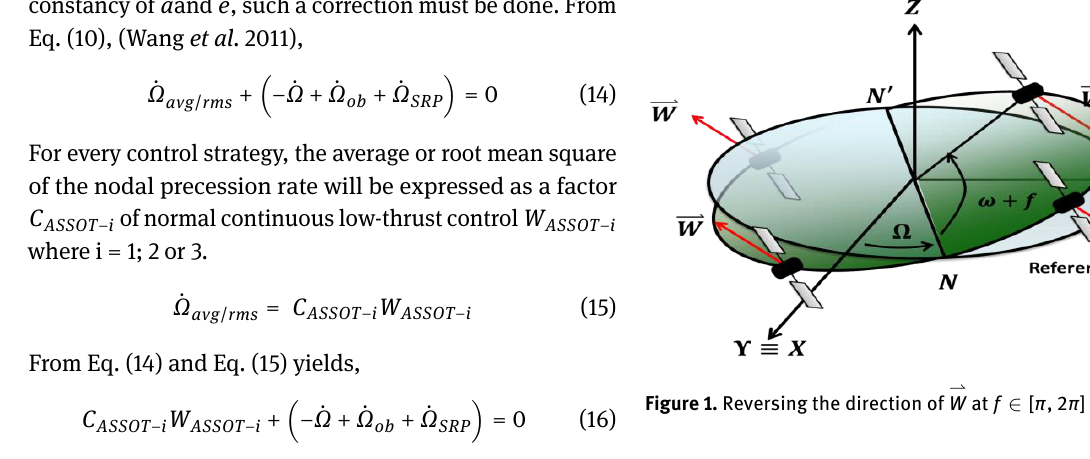
Figure 1. Reversing the direction of